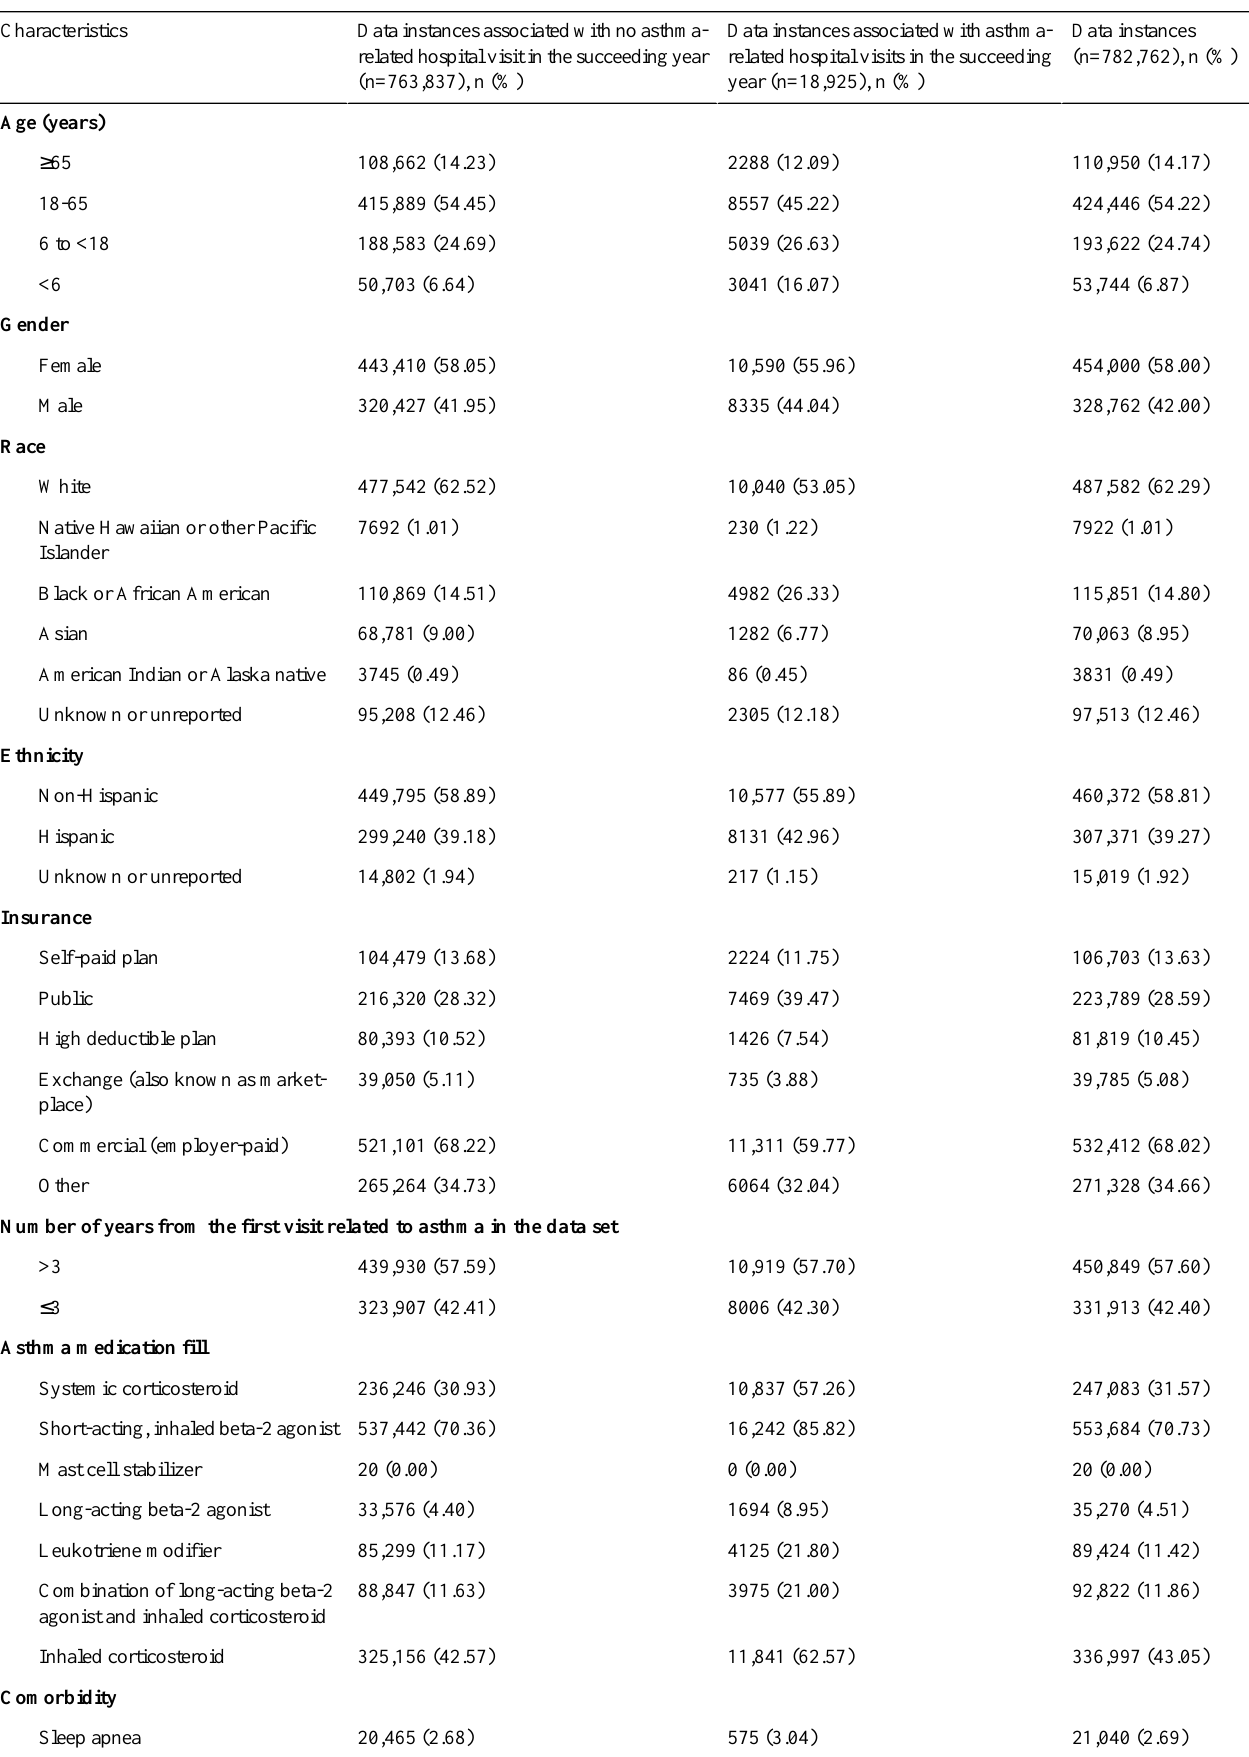
Table 1. Demographic and clinical characteristics of our Kaiser Permanente Southern California patient cohort during